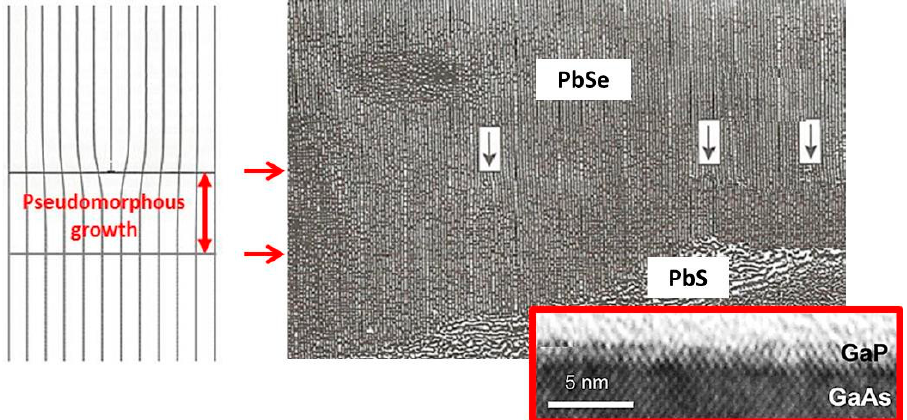
Figure 33. Pseudomorphous growth in the case of heteroepitaxy of PbSe on PbS [4]. (Reproduced from [4] with some modifications with the permission of World Scientific).The small image of the lower right corner shows a TEM image of an area of the pseudomorphous growth during heteroepitaxy of GaP on GaAs [85]. (Reproduced from [85] with the permission of AIP Publishing).